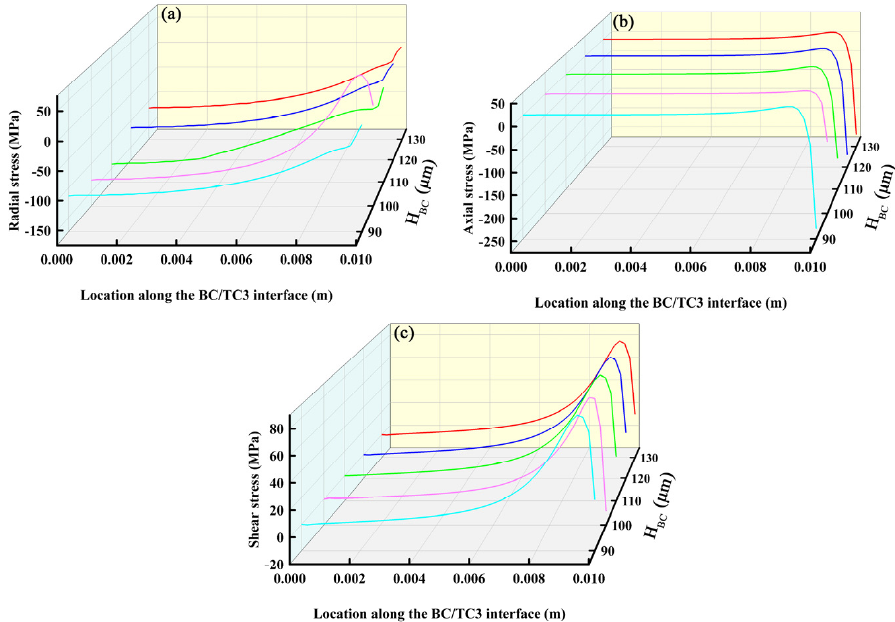
Figure 7. Stress distributions along BC/TC3 interface: ( a ) radial stress; ( b ) axial stress and ( c ) shear stress.